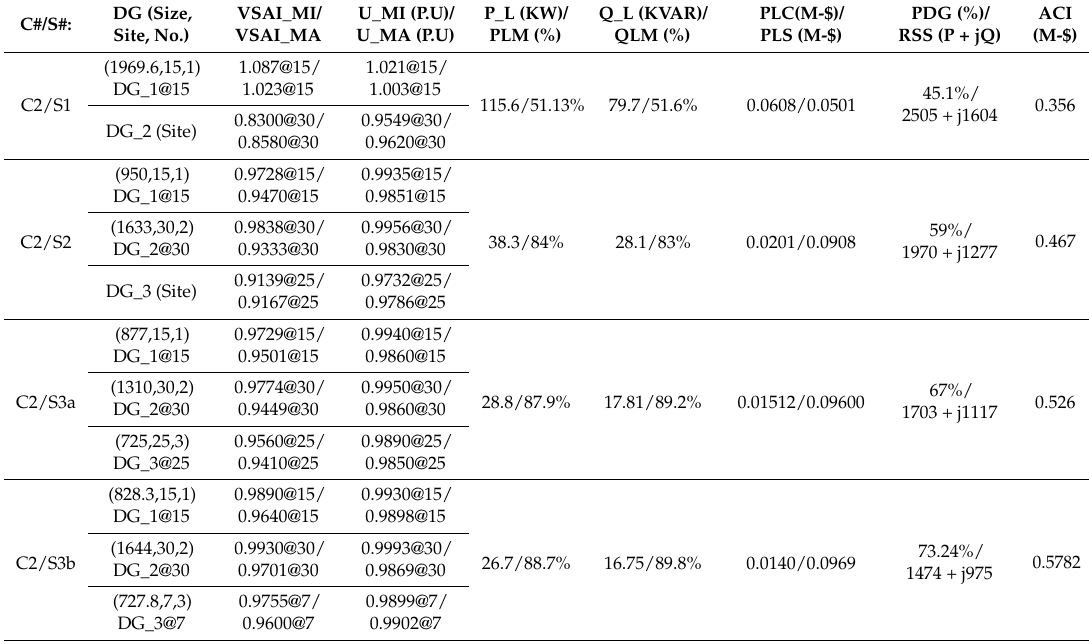
Table 3. Results of proposed planning approach under Case 2 (33-bus-MDS) aim at